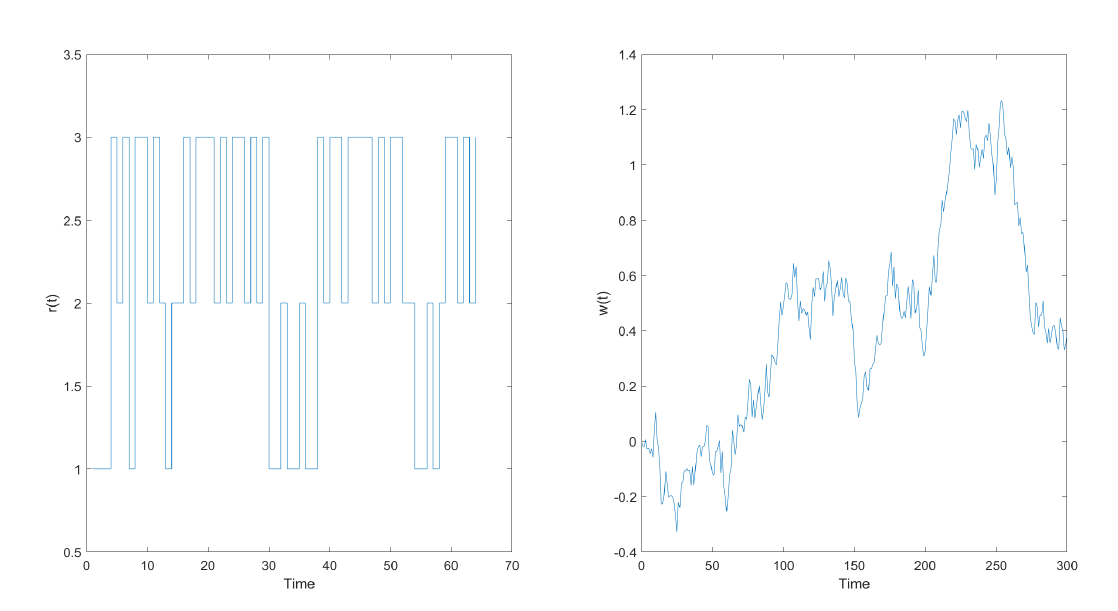
Figure 1. ( Left ) Setting the number of steps equal 64, we have a three states Markov chain stair figure. ( Right ) Setting the number of steps equal 300, we have a Brownian motion